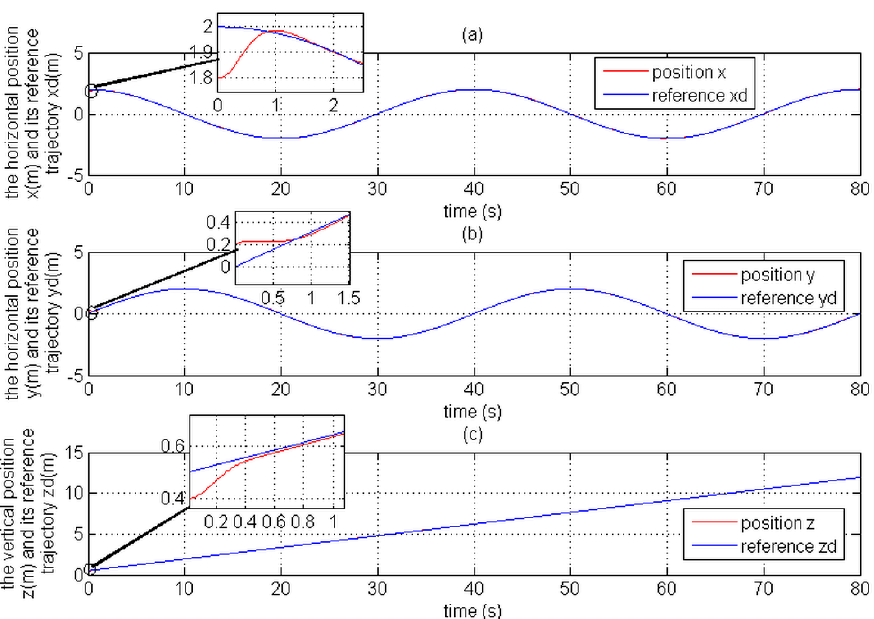
Figure 19. The position tracking evolution obtained by the PTCM: ( a ) x -position (m) and its reference trajectory x d (m); ( b ) y -position (m) and its reference trajectory y d (m); ( c ) z -position (m) and its reference trajectory z d (m).